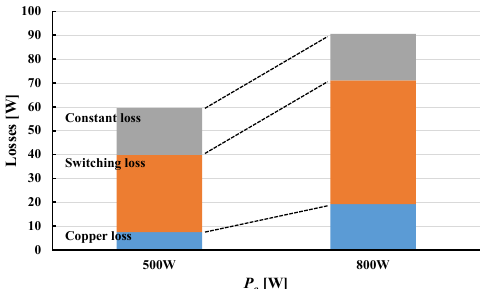
Figure 22. Loss comparison of parallel circuit when output voltage is 280 V.